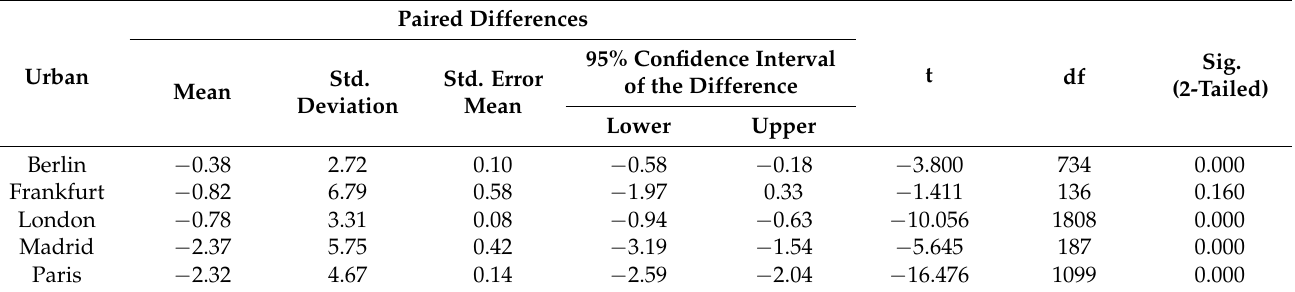
Table 6. Results of paired-samples t -test for NO 2 concentration data in the studied cities for the two Table 7. Difference in the averages of NUHI, NLST, NL, and NO 2 during COVID-19 lockdown com- periods. pared to its previous year.